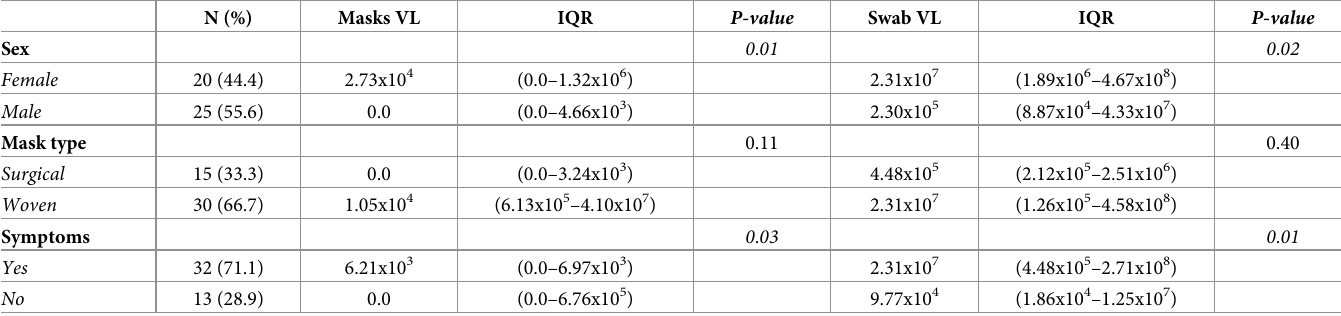
Table 2. Median viral load values of masks and nasopharyngeal swabs from 45 patients infected by